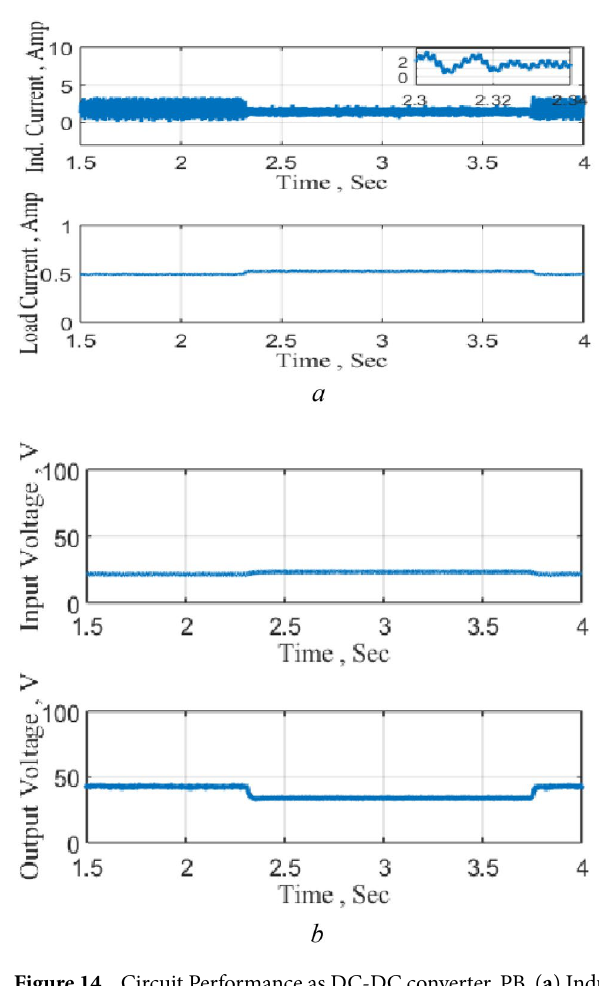
Figure 14. Circuit Performance as DC-DC converter, PB. ( a ) Inductor and output currents, ( b ) input and output